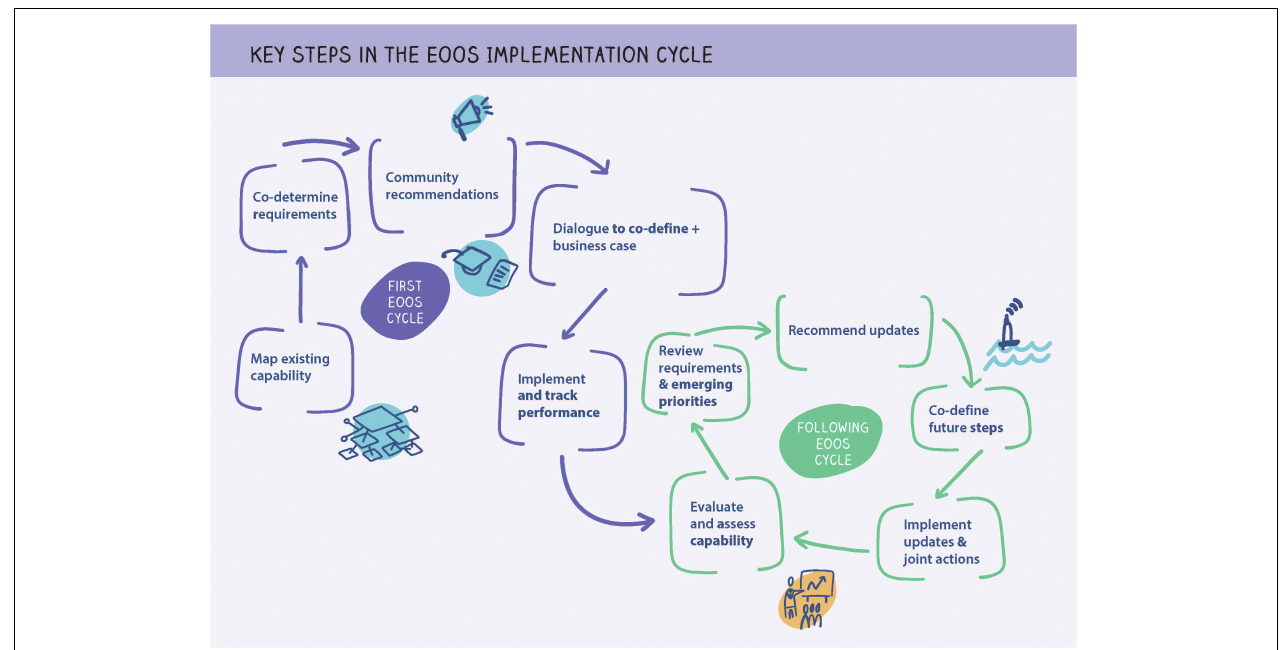
FIGURE 4 | Key steps in the EOOS implementation cycle showing the first cycle and then following cycles. Each cycle is proposed to last 5 years. Cross-cutting and intrinsic to each step in the EOOS cycle is stakeholder engagement, dialogue and co-design; communication and societal engagement; and governance and